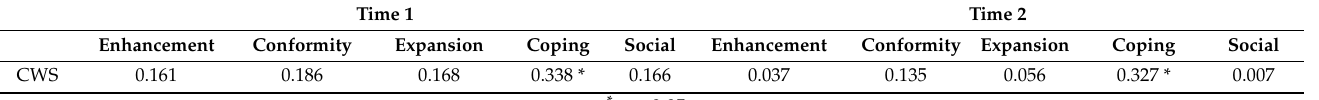
Table 3. Correlations between cannabis withdrawal symptoms (CWS) and cannabis use